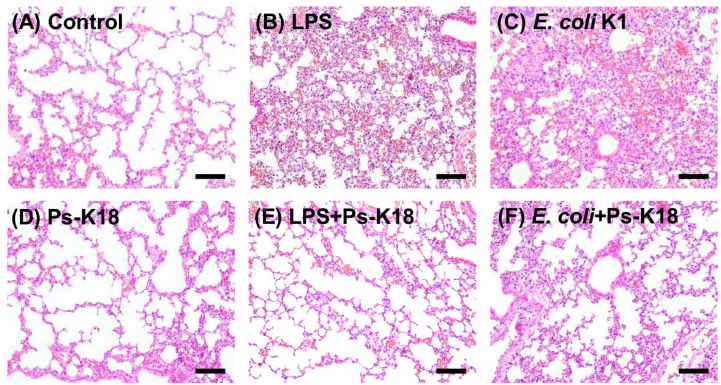
Figure 7. E ff ect of Ps-K18 on neutrophil infiltration in the lungs of septic shock mouse induced by LPS or E. coli K1. Lung morphology of ( A ) control, no peptide treatment, ( B ) LPS (15 mg / kg), ( C ) E. coli K1 (1 × 10 6 CFU / mouse), ( D ) Ps-K18 (1 mg / kg), ( E ) LPS + Ps-K18, injected with both LPS and Ps-K18, and ( F ) E. coli K1 + Ps-K18, injected with both E. coli K1 and Ps-K18. LPS or E. coli K1 was